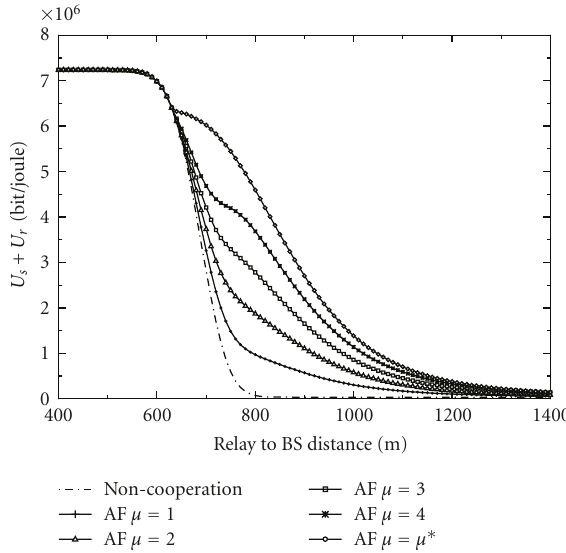
Figure 8: Sum utility of the cooperative system under AF forward-